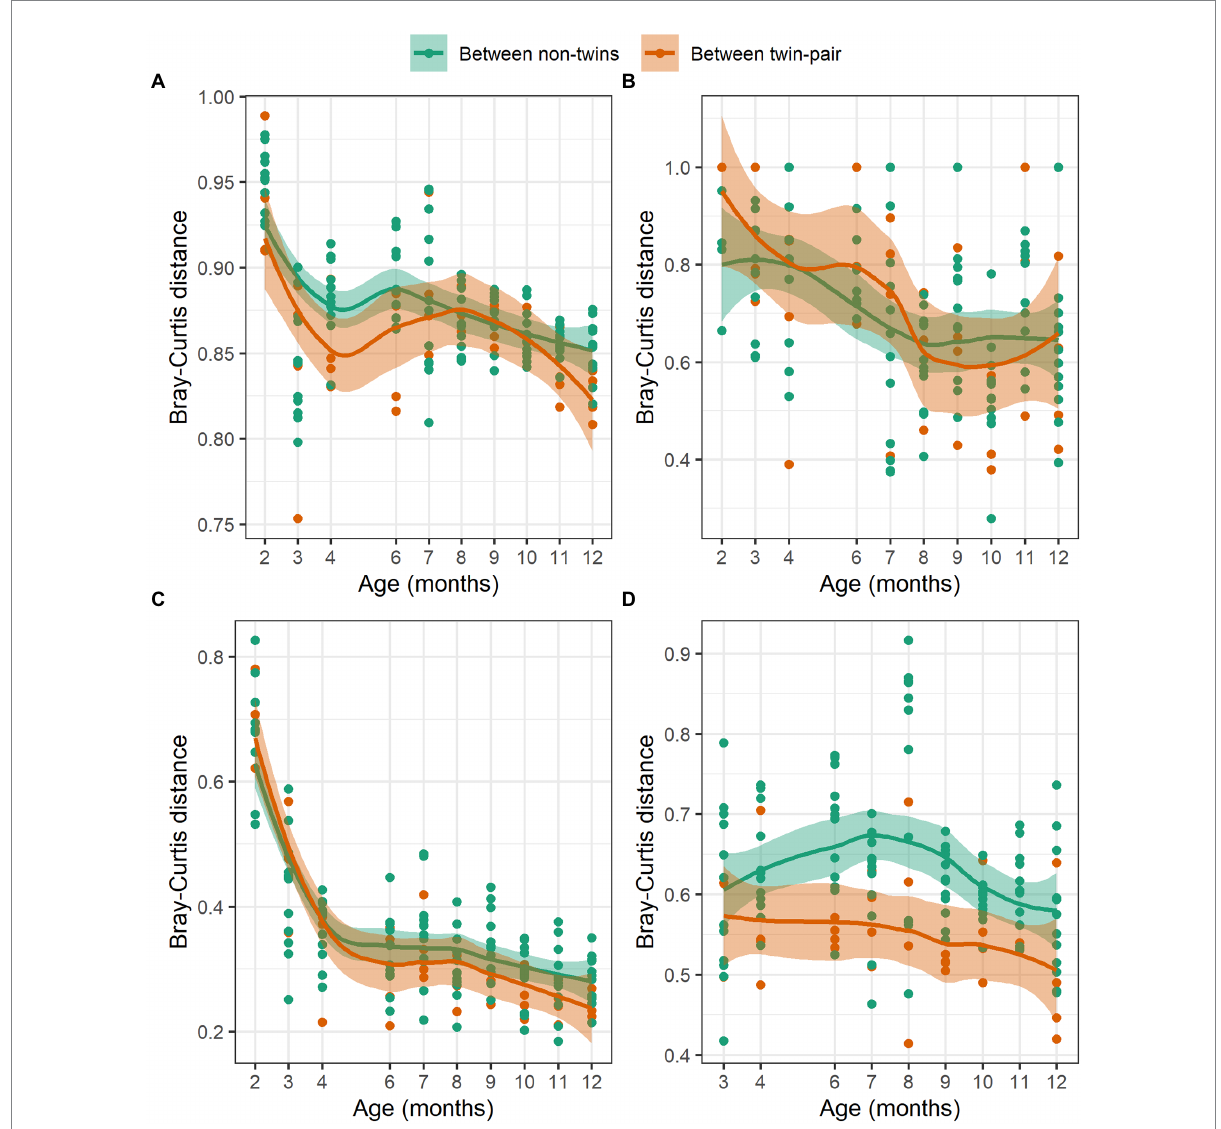
FIGURE 5 The Hellinger transformed Bray-Curtis distances of (A) bacteria, (B) archaea, (C) ciliate protozoa, and (D) anaerobic fungi communities between twin pairs (red) and between non-related heifers (green) at 2–12 months of